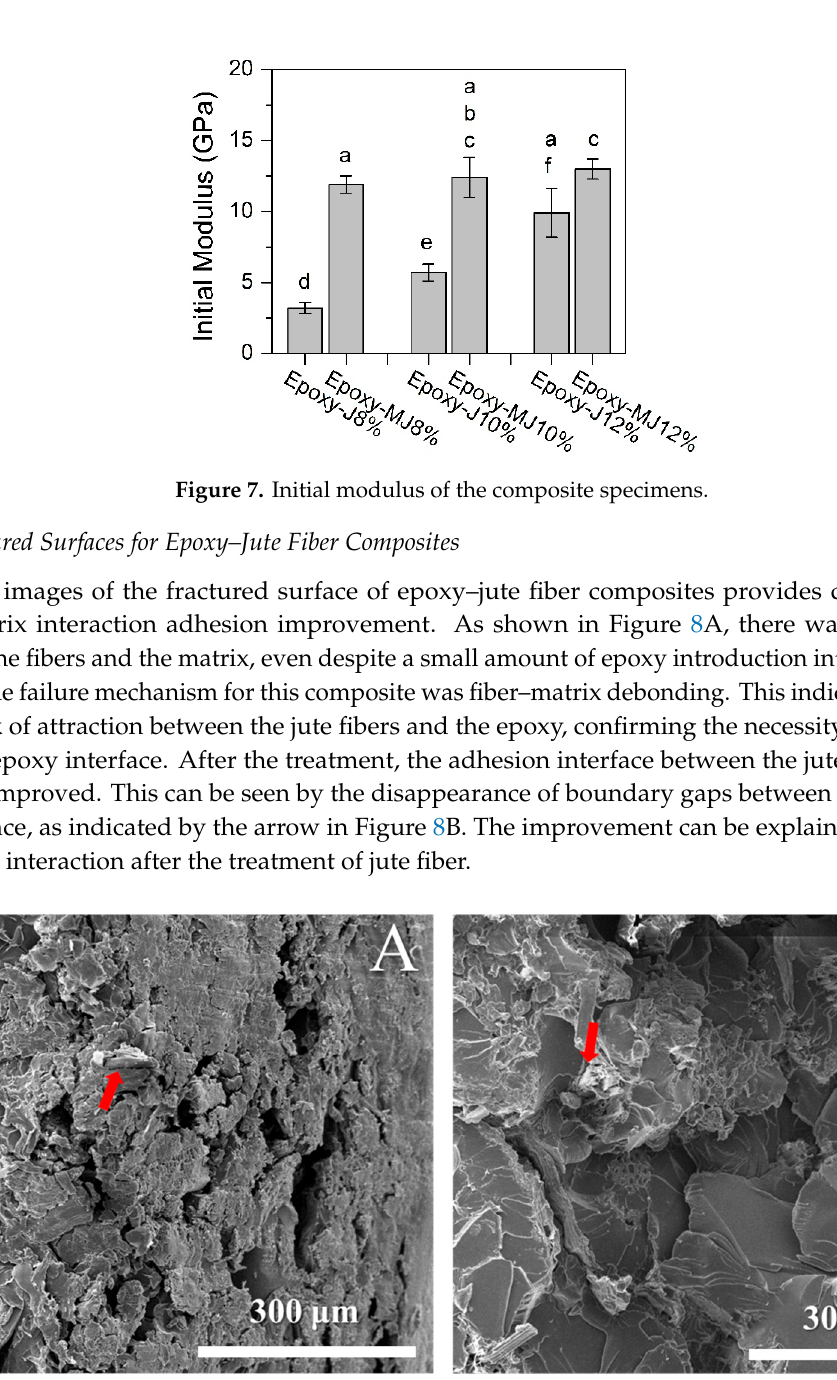
Figure 8. SEM of fractured surfaces ( A ) raw jute ( B ) treated jute composite.